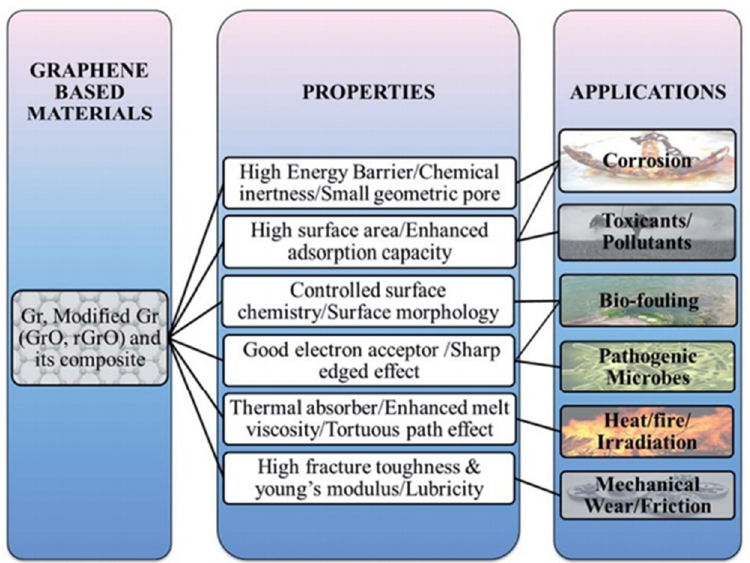
Figure 15. Preventive/shielding applications of graphene. “Reproduced with permission